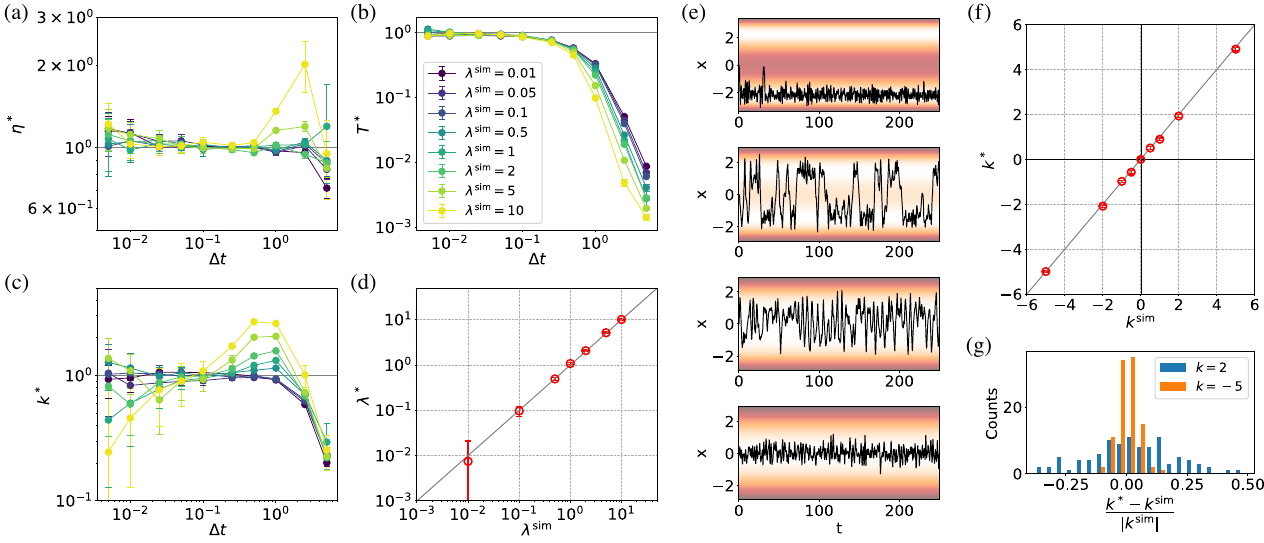
FIG. 2. Bayesian inference of the dynamical parameters of a Brownian motion in a force field f ð x Þ ¼ V 0 ð x Þ , with λ x 4 . Only the Toeplitz method is applied; as for the harmonic oscillator, in (a) – (d) and (f), ten sample trajectories V ð x Þ ¼ 1 kx 2 þ 1 2 4 of length 5000 points are considered for each Δ t . Error bars are 0.95 CI. (a) – (c) Inferred model parameters against subsampling parameter Δ t . The true value is equal to 1 in all cases and is marked by the straight gray line. (d) Inferred vs true value of the nonlinear coefficient λ . (e) Excerpts of sample trajectories in various landscapes. The strength of the confining potential is qualitatively indicated by the color map, with light areas corresponding to the minimum of the potential. The following parameters of the simulation are kept fixed: T ¼ 1 , η ¼ 1 , and λ ¼ 1 . By varying the parameter k , we realize, from top to bottom, a strong confinement in a double-well potential, with long exit times, at k ¼ − 5 ; a switching dynamics with relatively short switching times, at k ¼ − 2 ; a marginal situation at k ¼ 0 ; and confined Brownian motion in the vicinity of the origin at positive values of k ( k ¼ 5 ). (f) Inferred vs true value of the parameter of the linear force k , assuming both positive and negative values. (g) Histogram of counts for the relative distance of the inferred parameter k (cid:3) to the simulation parameter k sim . With fixed λ sim ¼ 1 and k sim ¼ f 2 ; − 5 g , the weight of anharmonicity varies, but the variance of all the estimated parameters seems to be unaffected. As a result, relative errors decrease for larger j k j . 100 trajectories are sampled for each k value shown in the histogram, and Δ t ¼ 0 . 025 in all